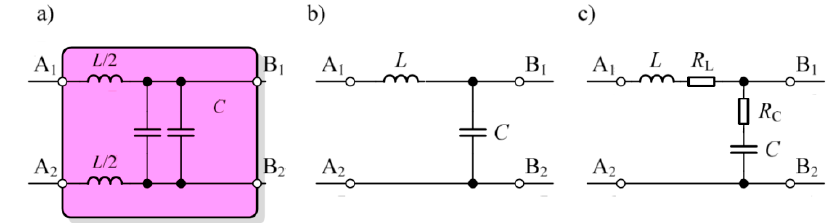
Figure 1. Scheme of the LC single-phase filter with two 33 μ H inductor chokes and two 100 nF capacitors: ( a ) scheme, ( b ) a substitute scheme of the ideal filter, ( c ) a filter scheme with the resistive parasitic elements indicated.